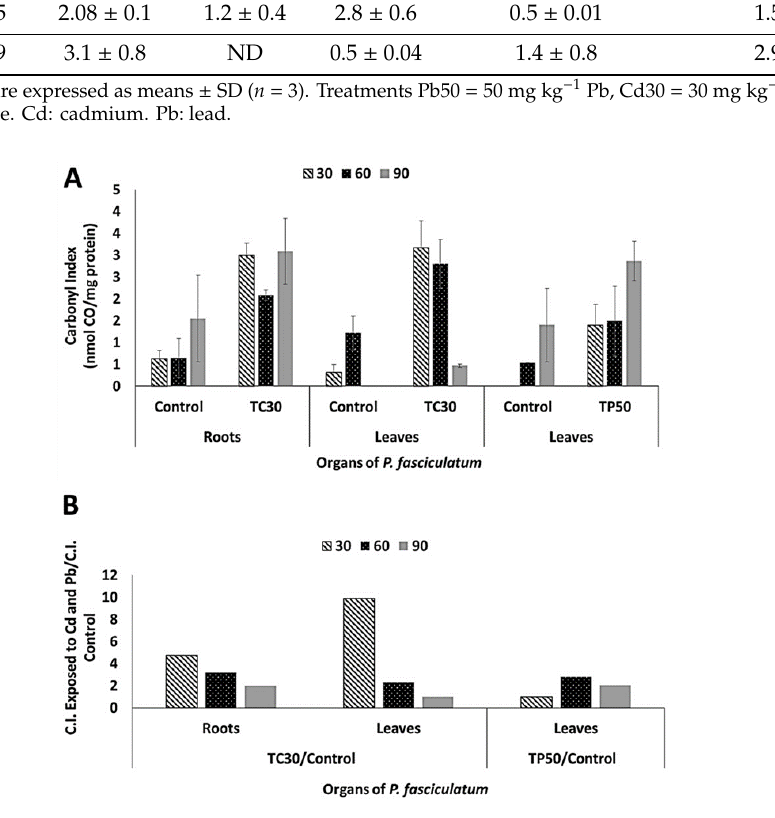
Figure 3. Carbonyl indexes in roots and leaves proteins of P. fasciculatum exposed to Cd and Pb at dissimilar days. ( a ) Evidence variation of C.I [means ± Standard Desviation (SD)] for each control, roots and leaves in exposition assays to 30 mg kg − 1 Cd and leaves exposed to 50 mg kg − 1 Pb. ( b ) Relation increase of C.I values for samples exposed to Cd and Pb/Control.